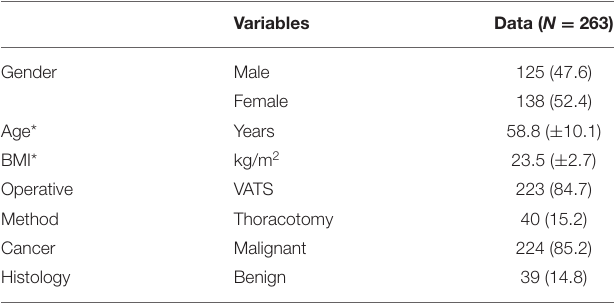
TABLE 1 | Baseline characteristics of patients.